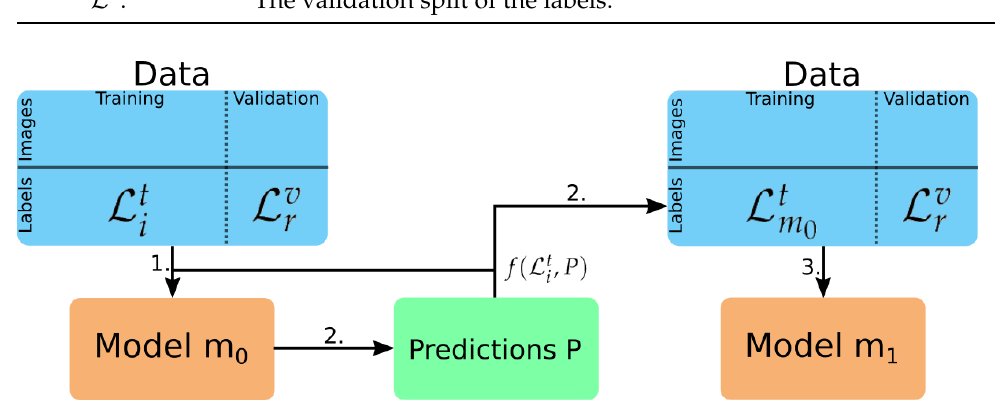
Figure 5. Illustration of the procedure of both